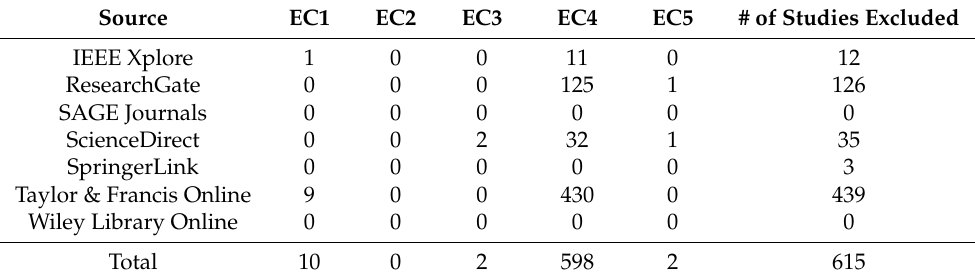
Table A1. Exclusion of papers based on each exclusion